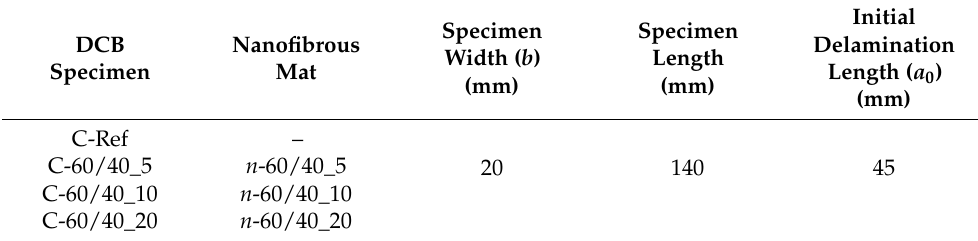
Table 2. Details of produced DCB specimens.